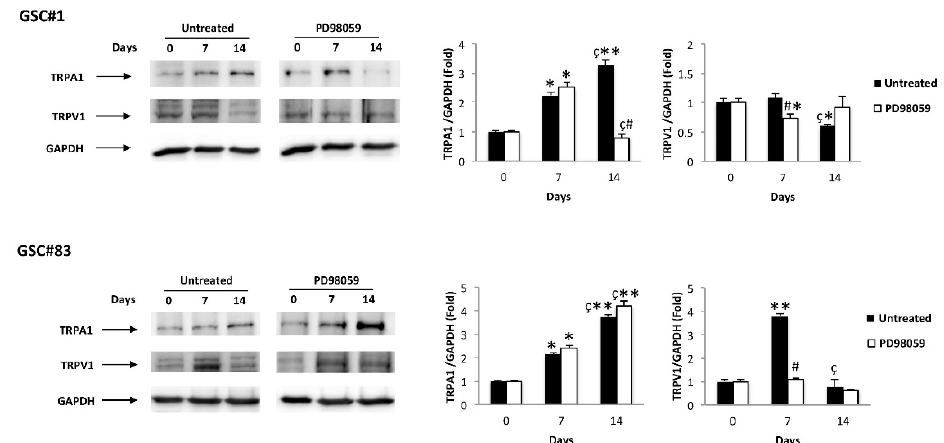
Figure 5. TRP modulation during GSC differentiation: western blot analysis of TRPA1 and TRPV1 protein levels in GSC#1 and GSC#83 untreated or treated with PD98059 for up to 14 day of differentiation. Blots are representative of one of three separate experiments. TRPA1 and TRPV1densitometry values were normalized to GAPDH used as loading control. * p < 0.01 vs. undifferentiated cells (time 0); ** p < 0.001 vs. undifferentiated cells (time 0); # p < 0.001 vs. untreated cells; ç p < 0.01 vs. 7 days of differentiation.